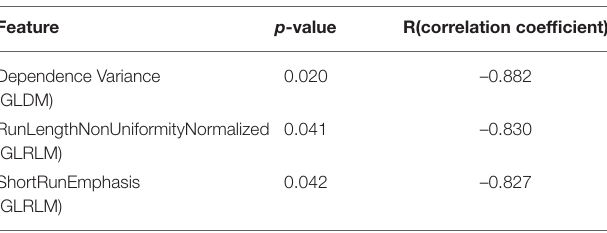
TABLE 1 | Distribution of the three most prominent features associated with RAS+ vs. RAS- for 72, 96, and 120 hpf zebrafish larvae. Feature p